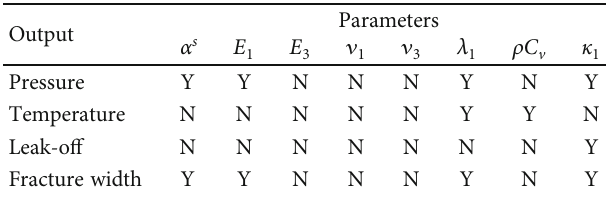
Table 4: Sensitivity analysis summary showing which input parameters in fl uence the solution. Y is for yes and N is for